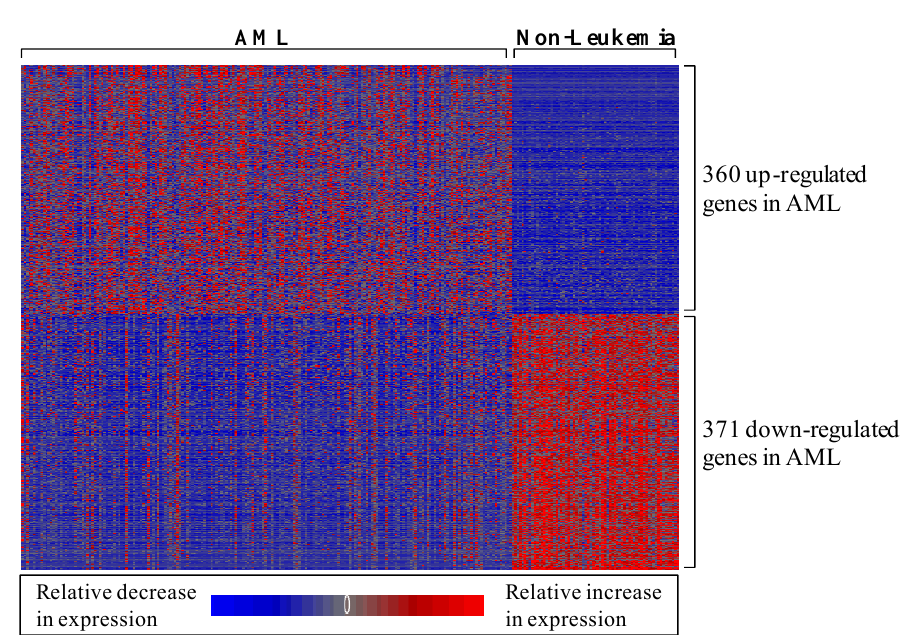
Figure 2. Heat map displaying the relative expression levels of the 731 AML-associated genes. Expression levels are z-score